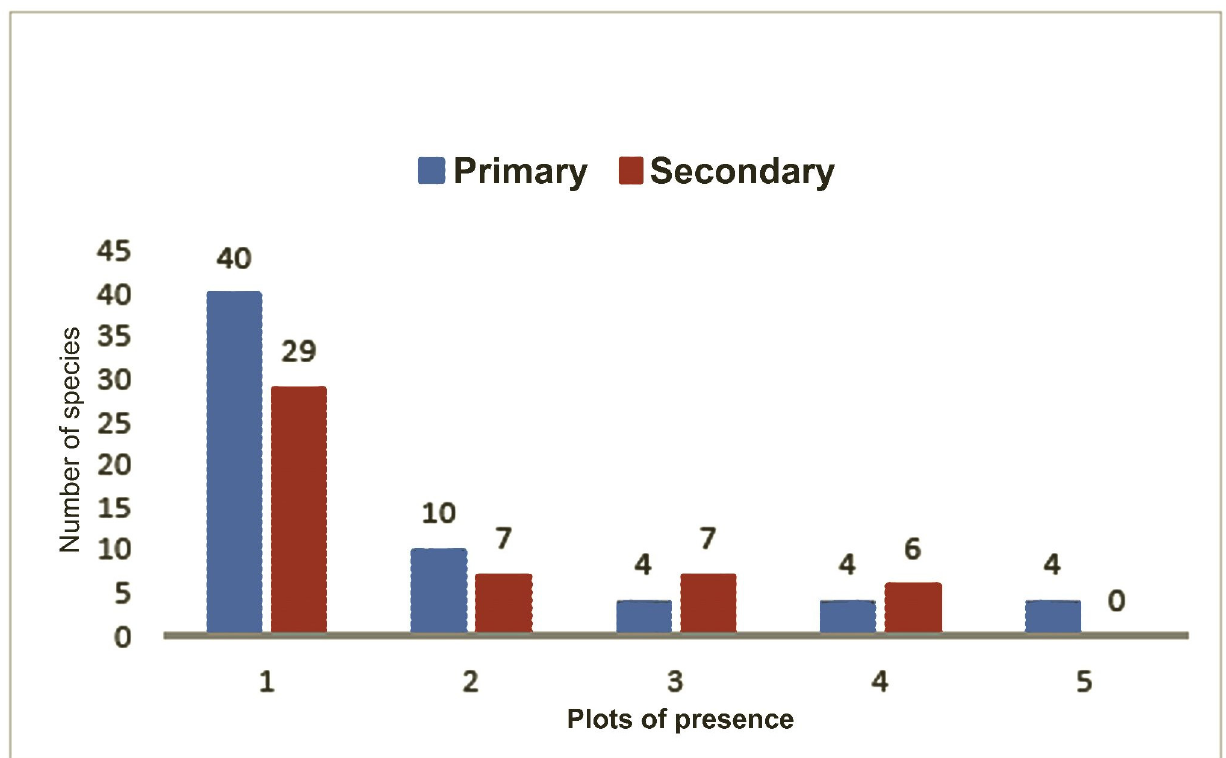
Figure 8. Abundance of species in relation to the number of plots where they have been collected. Otonga, primary and secondary forest.